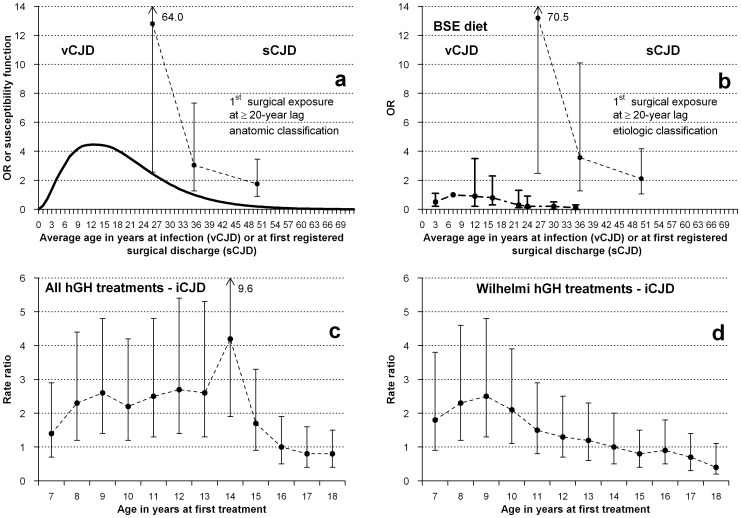
Potential age-at-exposure-related susceptibility for the following different CJD forms and exposures:(a) Age-susceptibility function for vCJD in the UK [12], and results from Table 1 for risk of sCJD from age at first hospital discharge associated with a registered, main surgical procedure, at a lag of ≥20 years. (b) Reported estimated risks relating to 5- to 10-year age groups, after adjustment for dietary exposure to bovine material and average incubation period established at 12.6 years for variant CJD in the UK [13], and plotted results from Table 1 for risk of sCJD from age at first hospital discharge associated with an etiologically reclassified higher-risk or lower-risk procedure, at a lag of ≥20 years. (c) Reported rate ratios of accidentally transmitted CJD (iCJD), for ever treatement vs never treatement with pituitary growth hormone (all treatments) at specific ages [11]. Reference: all other ages at treatment. (d) Reported rate ratios of accidentally transmitted CJD (iCJD) for ever treatment vs never treatment with pituitary growth hormone processed with the Hartree-modified Wilhelmi method (an hGH preparation associated with highest risk of iCJD among hGH-treated cohorts) at specific ages [11]. Reference: all other ages at treatment.